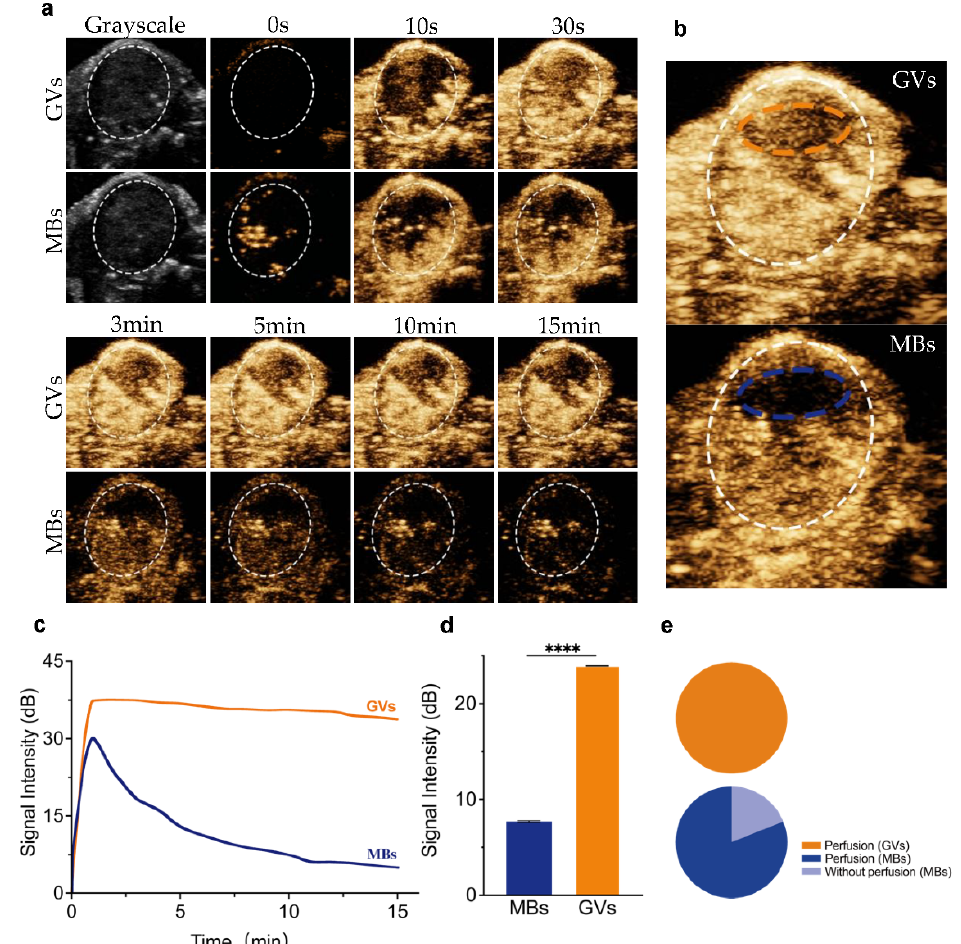
Figure 5. Ultrasound imaging of GVs and lipid MBs in tumor: ( a ) B-mode and nonlinear contrast images of GVs and MBs in 15 min after tail injection; ( b ) nonlinear contrast images of the ischemic zone of a tumor after injection of GVs (orange-dotted circle) or MBs (blue-dotted circle); ( c ) time– intensity curve of GVs and MBs perfused into the tumor tissue; ( d ) contrast signal intensities of GVs and MBs in the tumor’s ischemic zone (orange- and blue-dotted area); ( e ) the perfusion area of GVs and MBs in the tumor. Error bars represent ± SD. **** p < 0.0001.